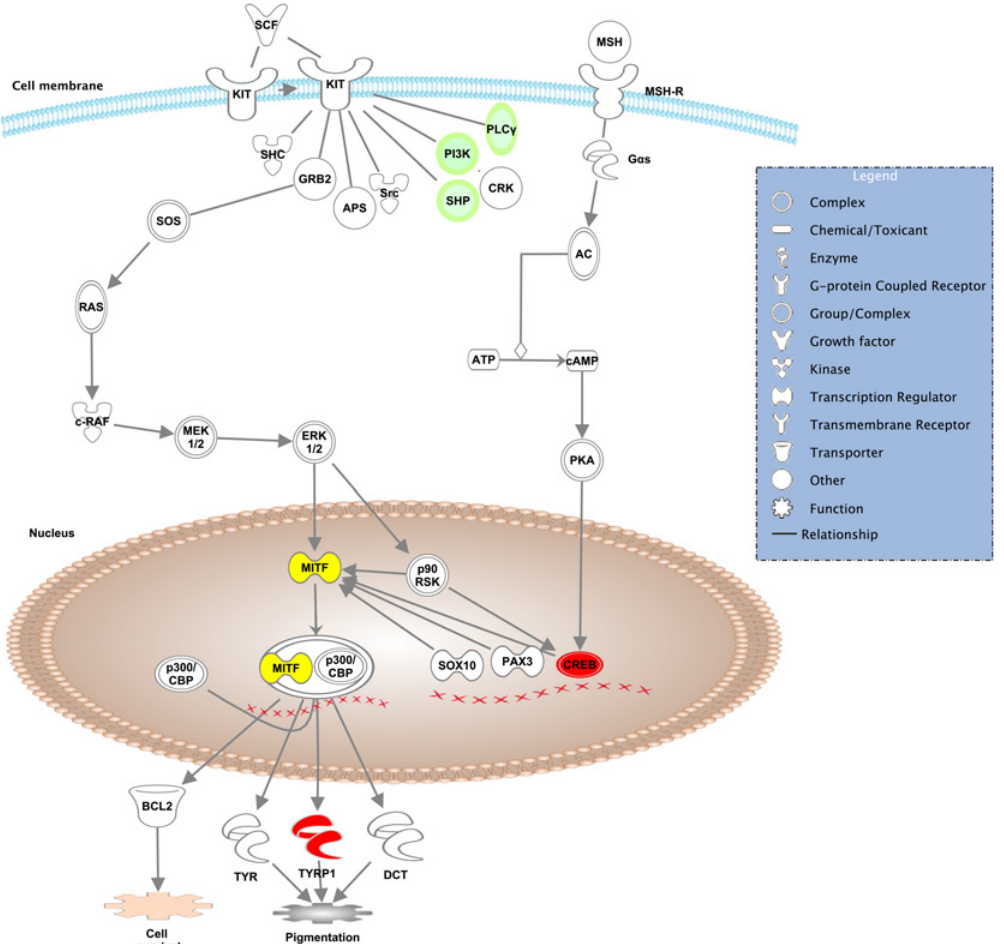
Fig 2. Genes known to be associated with melanocyte development and pigmentation signaling. Red and green colored gene symbols are increased or decreased, respectively, in melanoma fishes compared to control. The mitf gene (yellow) is upregulated but fails to reach statistical significance.